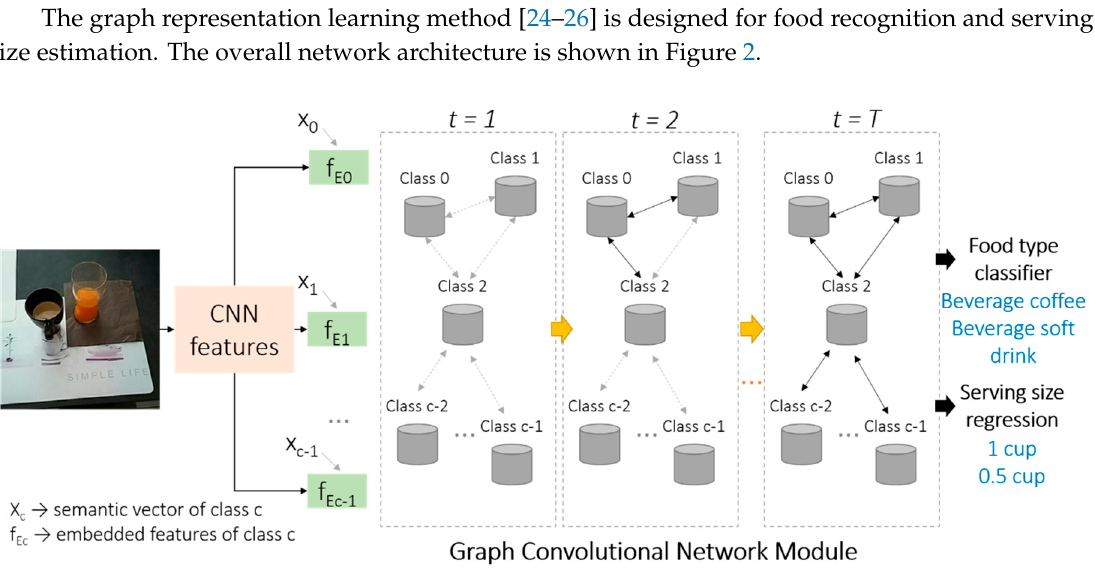
Figure 2. Overall framework of graph representation learning for multi-label food recognition and serving size prediction. c is the index of the food category; t indicates the iterative process for the graph convolutional network module